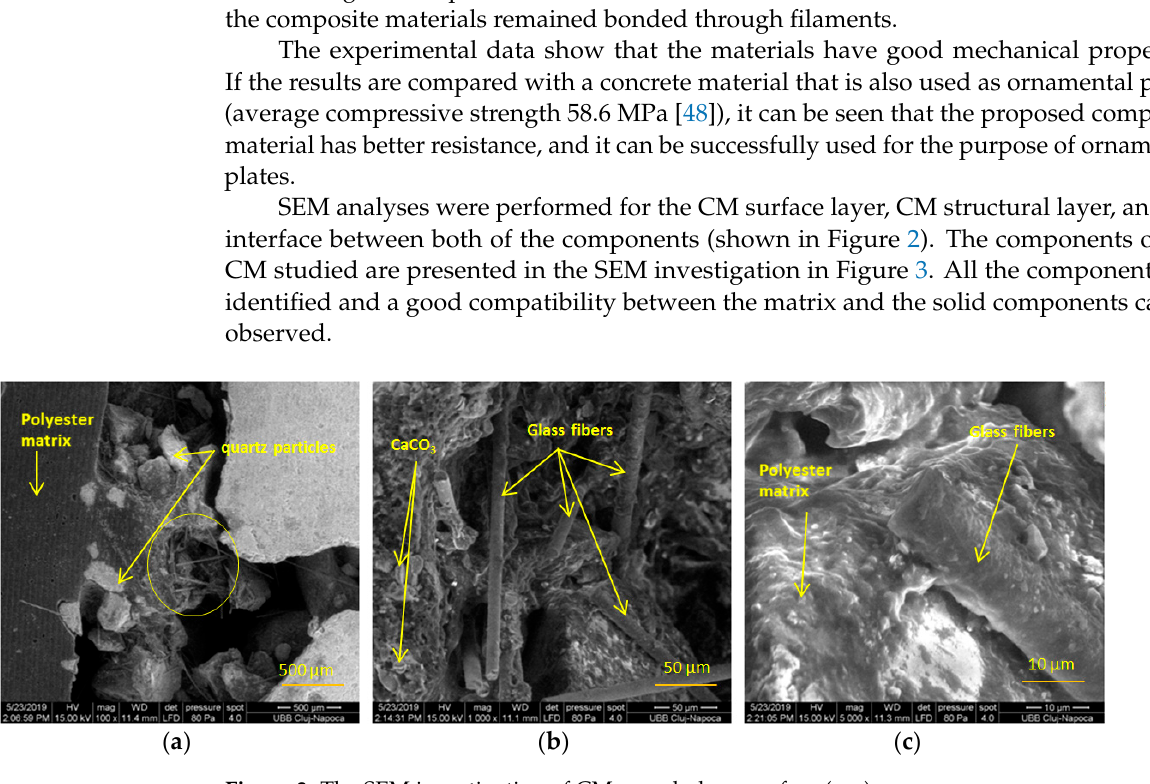
Figure 3. The SEM investigation of CM morphology surface ( a – c ).